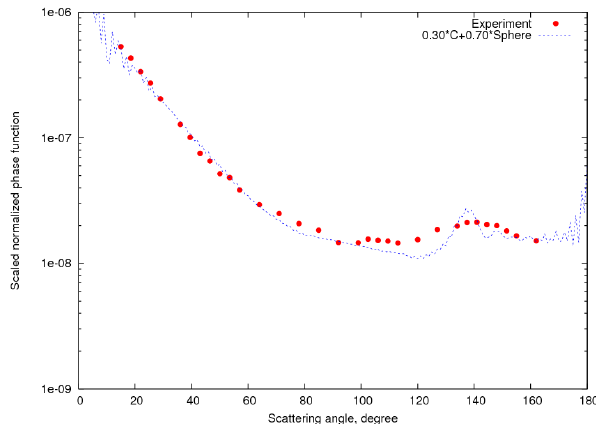
Fig. 5. The scaled normalized scattering phase function plotted against the scattering angle. Showing, the PN measured average phase function (filled red circles) and weighted habit mixture model 1 (0.4*T3 (0.03)+0.6*T3 (0.1)), which is represented by the blue dashed line.